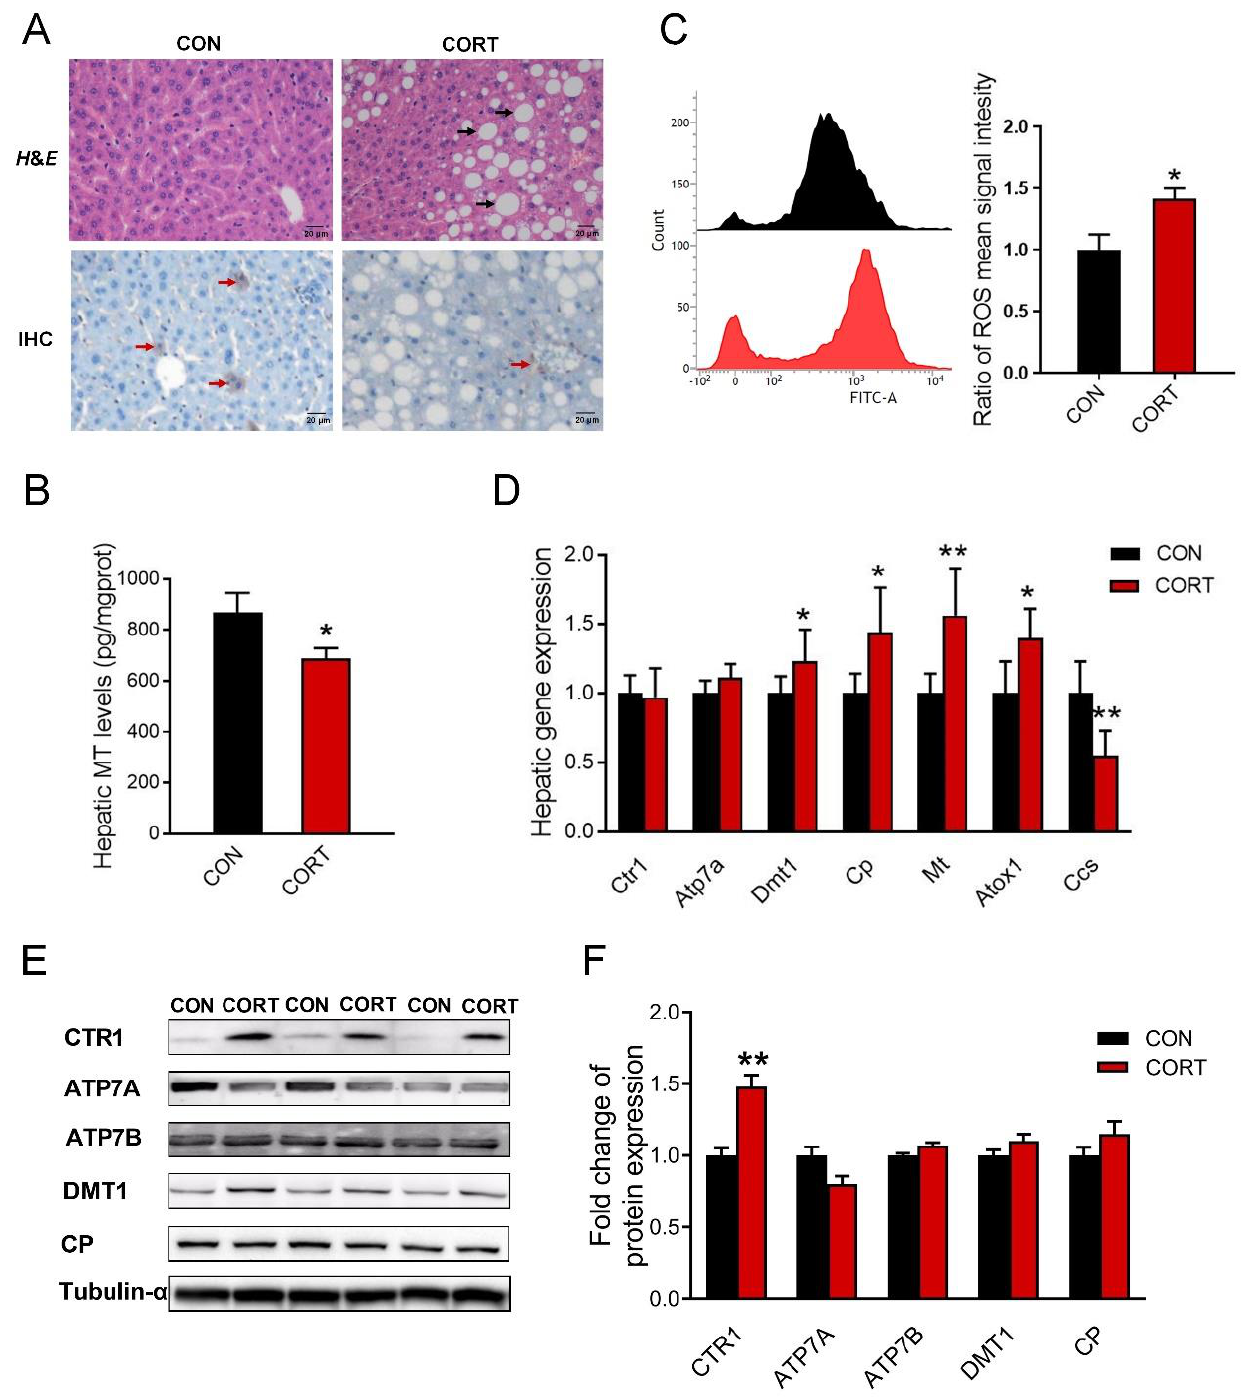
Figure 3. Chronic corticosterone exposure induces hepatic damage and disrupts hepatic copper metabolism in mice. ( A ) H&E staining of mouse liver and immunohistochemistry of metallothionein (n = 3); black arrow: lipid droplets; red arrow: metallothionein position. ( B ) The content of metal- lothionein in mouse liver detected by ELISA kit (n = 8). ( C ) Intracellular ROS levels were measured using flow cytometry (n = 3). ( D ) mRNA expression of Ctr1 , Atp7a , Dmt1 , Cp , Mt , Atox1 and Ccs were evaluated by qPCR (n = 6). ( E , F ) Western blot analyses of CTR1, ATP7A, ATP7B, DMT1, CP and Tubulin- α proteins (n = 6). CON =control group; CORT = corticosterone exposure group. Values are means ± SEM, * p < 0.05, ** p <